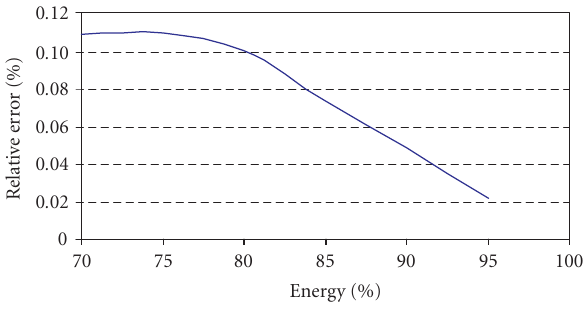
Figure 5: Results from reconstructed images from spiral sampling for image size 128 × 128 showing reconstruction relative error for retained energy levels between 70- 95%. The number of elements per row increases dramatically after 95%